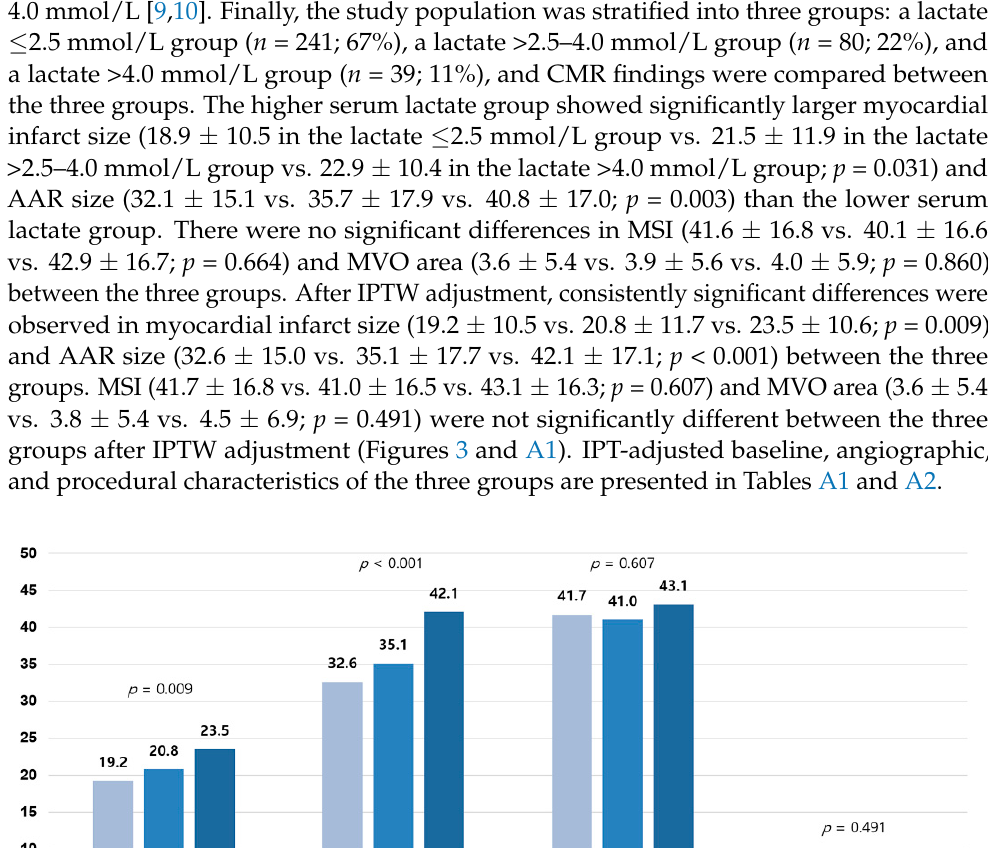
Figure 4. Predictors of large myocardial infarct. Forest plots show the results of multivariate analysis of predictors of large myocardial infarct. CI = confidence interval. 4. Discussion The association between serum lactate level and myocardial injury was investigated in patients with AMI using CMR markers of myocardial and microvascular damage. The main finding of this study is that in AMI patients undergoing PCI, high serum lactate is associated with greater myocardial infarct size and extent of AAR, as assessed by CMR. In multivariate analysis, high serum lactate was associated with larger myocardial infarct, and the association between high serum lactate and advanced myocardial injury was con- sistent across various subgroups. To the best of our knowledge, this is the first study to